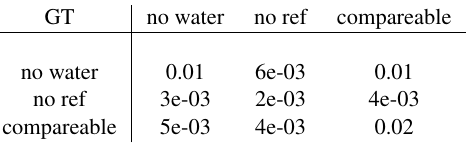
Table 3. conf Matrix preproz. 1m, enh 3m, change